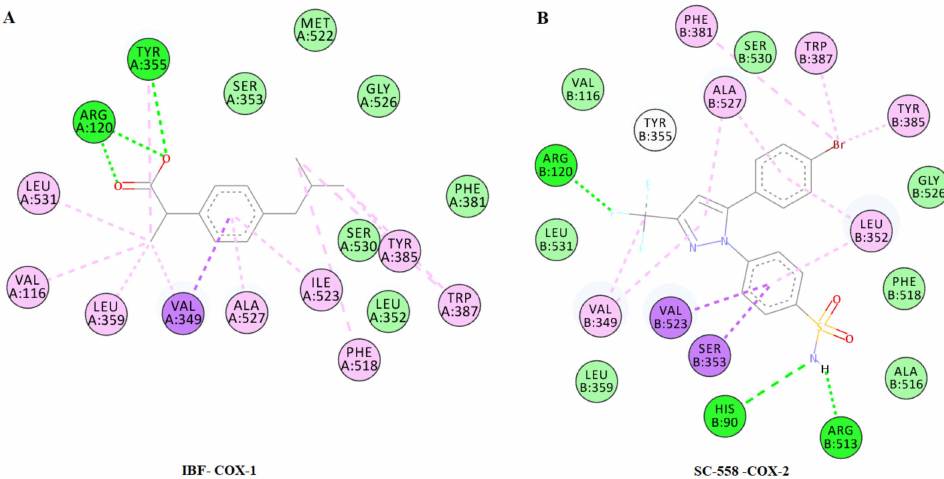
Figure 2. ( A ). Docking pose of co-crystallized ligand, ibuprofen ( S ) (IBF), in the COX-1 active site. ( B ) Docking pose of co-crystallized SC-558 inhibitor in the COX-2 active site. SC-558 inhibitor binds to the active site of COX-2 by forming a weak H-bond